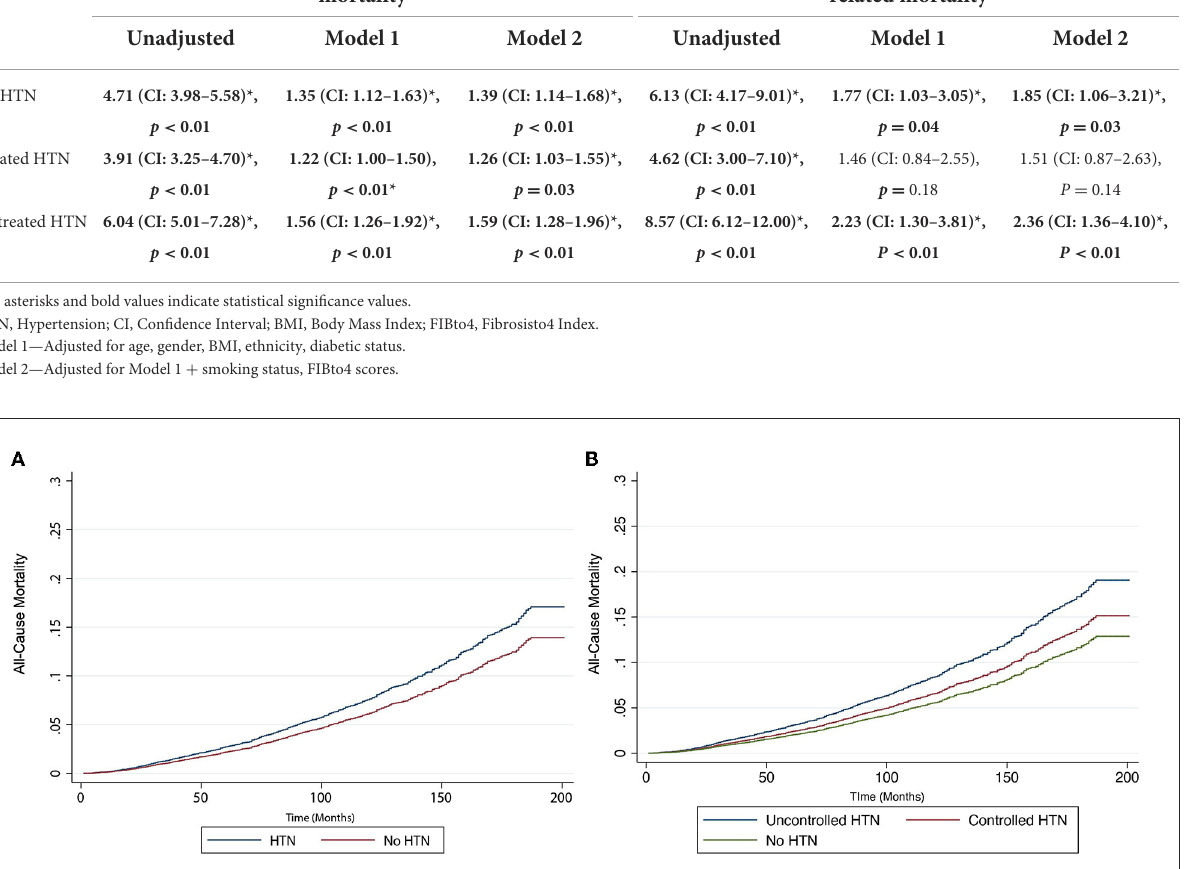
TABLE 3 All-cause mortality and cardiovascular related mortality in individuals with hypertension, treated hypertension and untreated hypertension. All-cause Cardiovascular mortality related mortality Unadjusted Model 1 Model 2 Unadjusted Model 1 Model 2